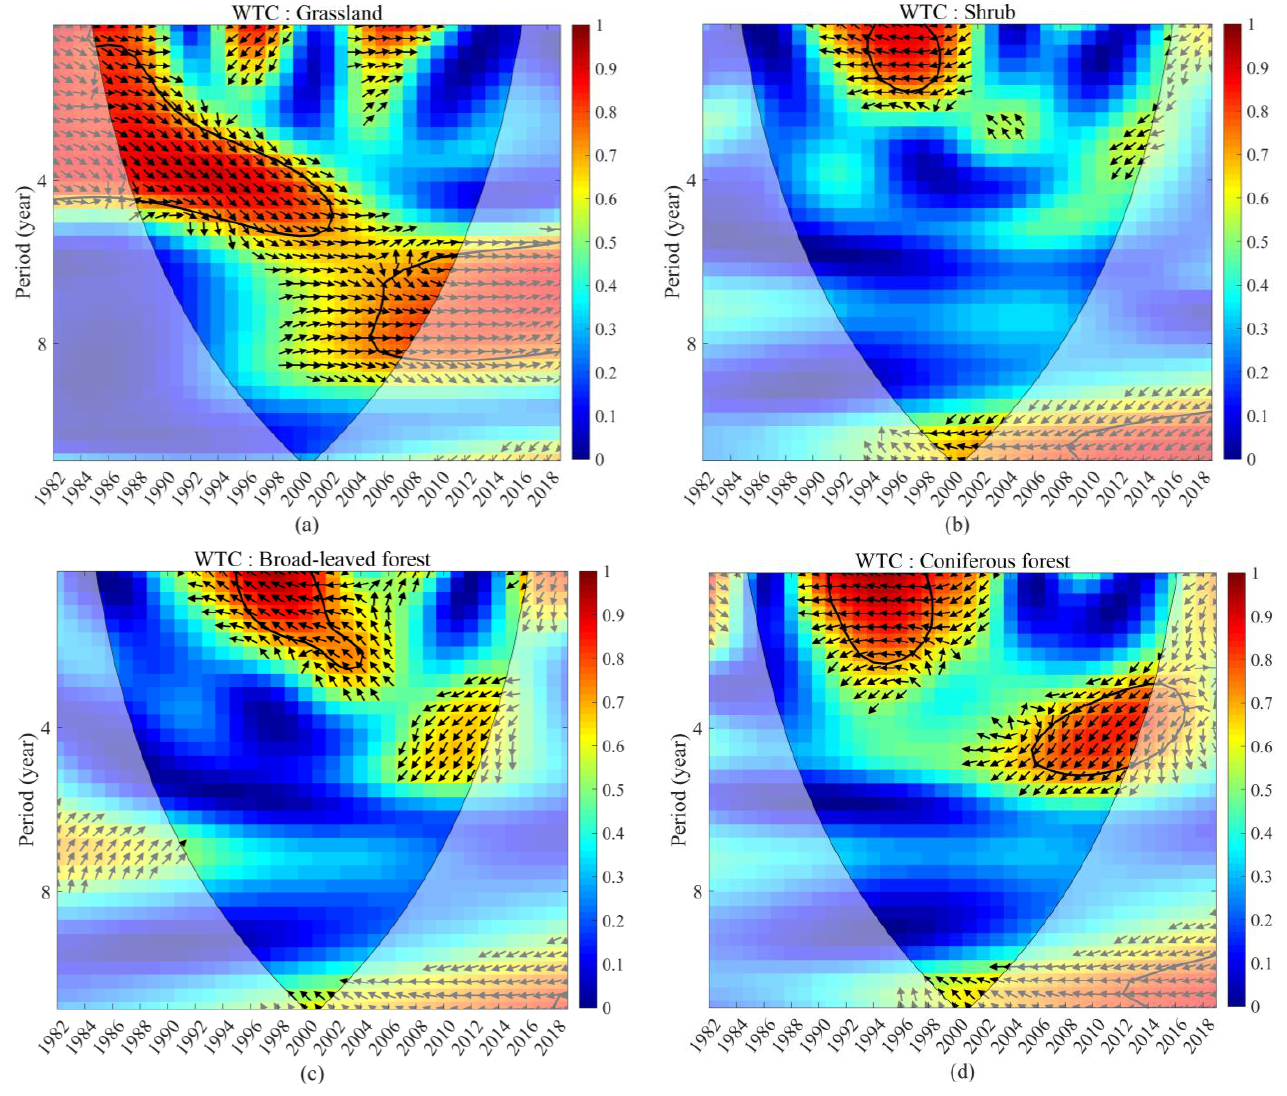
Figure 14. WTC condensation spectrum results of SPEI and NDVI of grasslands ( a ), shrubs ( b ), broad-leaved forests ( c ), and coniferous forests ( d ). The meanings of the colors, lines, and areas are the same as those in Figure 13.